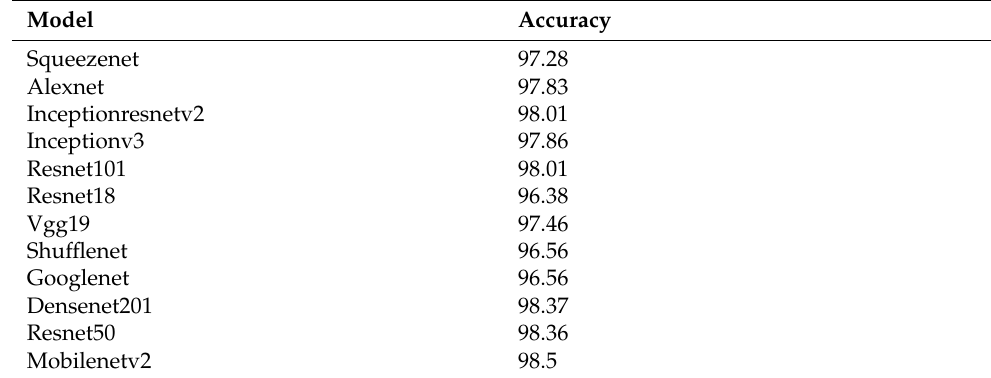
Table 4. Accuracy comparison among the Inceptionresnetv2 and deep-features SVM